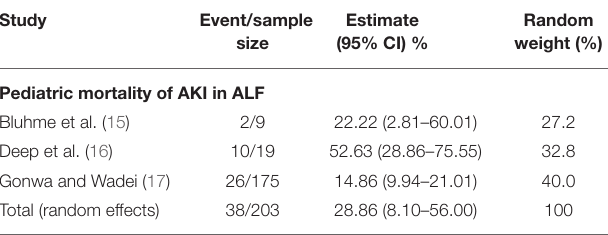
TABLE 3 | Meta-analysis of proportion of mortality among AKI patients with ALF across different